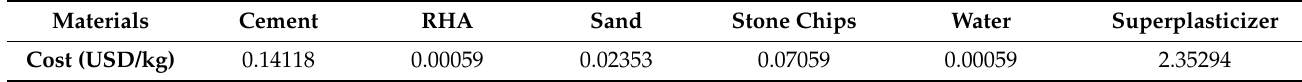
Table 8. Local prices of the